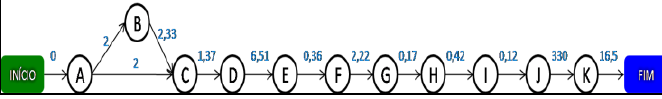
Figura 4: Diagrama de Rede do cenário encontrado. Fonte: Autores, (2018).